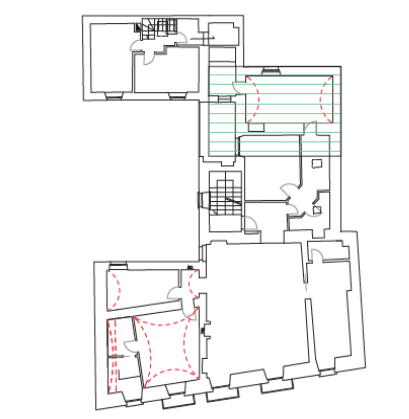
Figure 3: second floor with green identification of the intervention